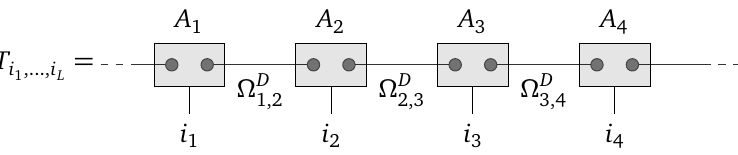
Figure 1: Matrix product states as a network of maximally entangled states Ω D shared between physical sites of the 1D lattice to which local operations A plied on combined virtual space on each